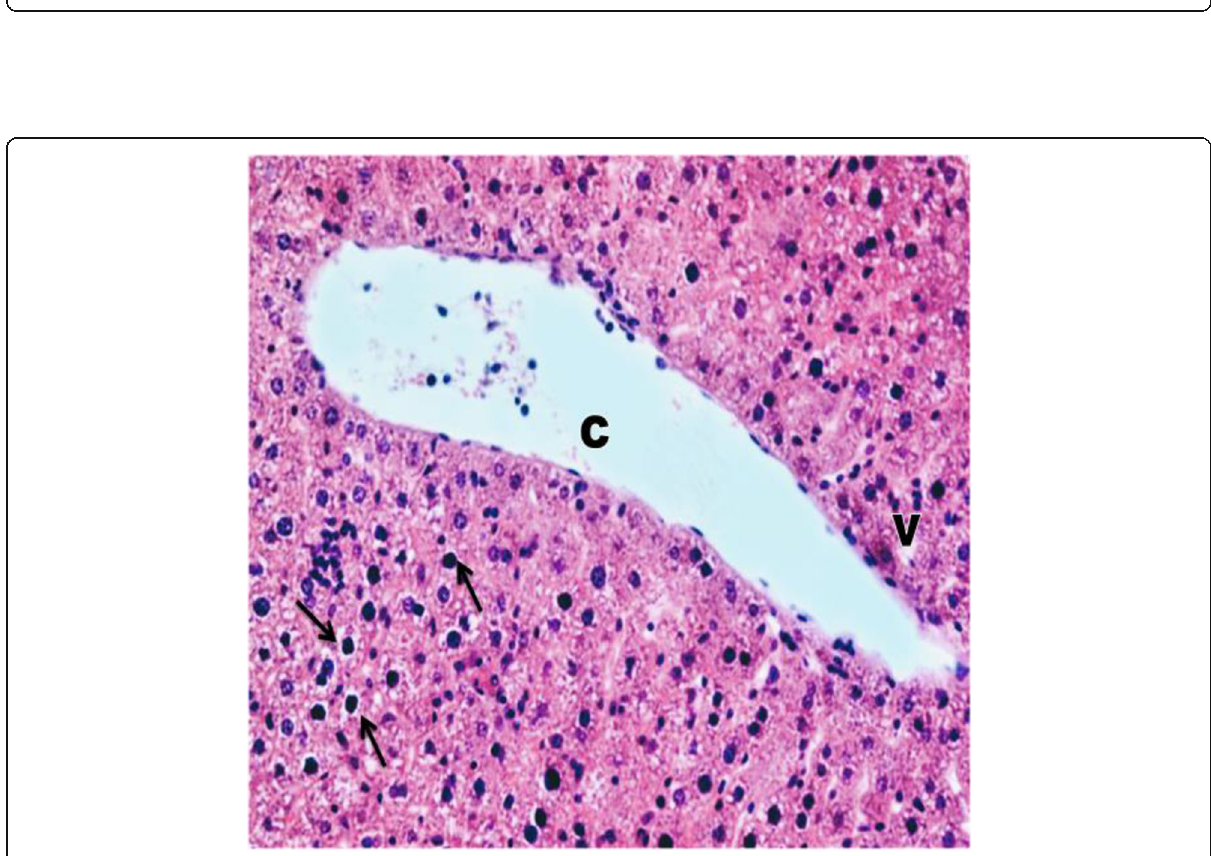
Fig. 4 Photomicrograph of a section of the liver of treated mouse with Tamiflu (16 mg/kg b.wt.) for 10 days revealing inflammatory cells (INF) in the vicinity of enlarged and congested hepatic portal vein (HPV). (H&E, ×